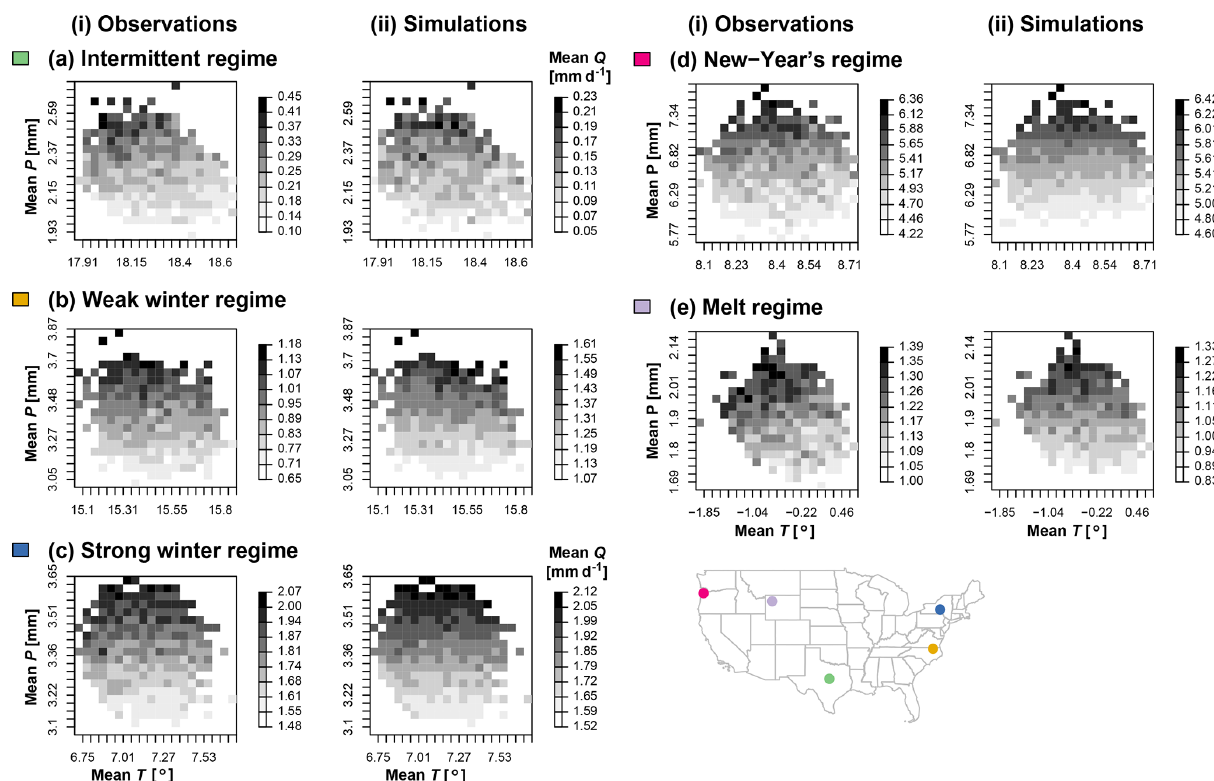
Figure 4. Climate sensitivity analysis for observations (i) and simulations (ii): dependence of mean discharge ( Q ) on precipitation ( P ) and temperature ( T ) for five example catchments, one per regime class: (a) intermittent regime: Cowhouse Creek at Pidcoke, TX (USGS 08101000); (b) weak winter regime: Potecasi Creek near Union, NC (USGS, 02053200); (c) strong winter regime: Otselic River at Cincin- natus, NY (USGS 01510000); (d) New Year’s regime: Tucca Creek near Blaine, OR (USGS 14303200); and (e) melt regime: South Fork Shoshone River near Valley, WY (USGS